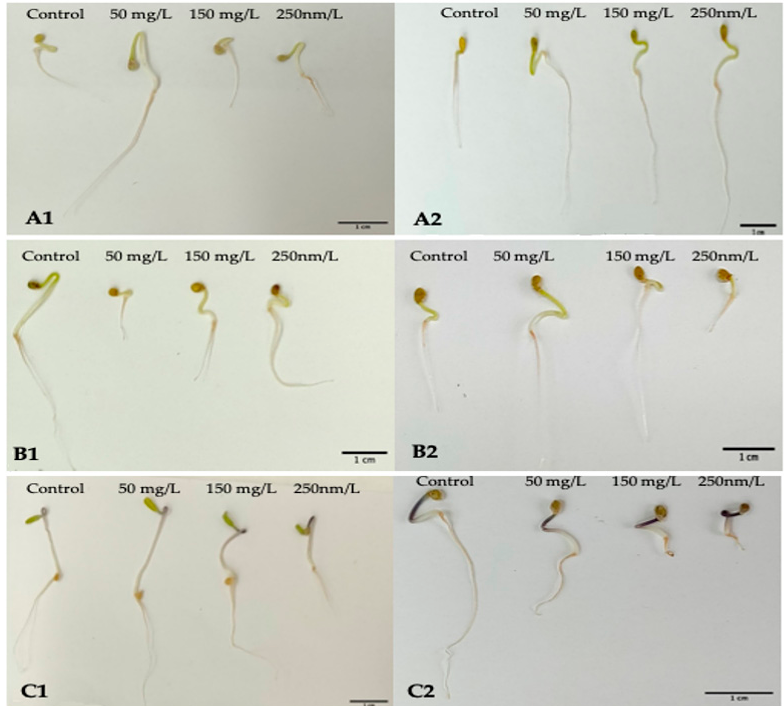
Figure 9. The picture of seedlings after 5 days of incubation. The seedlings of Maskotka cultivar treated with the suspensions of NPs ( A1 ) <50 nm and ( A2 ) <100 nm. The seedlings of Granit cultivar treated with the suspensions of NPs ( B1 ) <50 nm and ( B2 ) <100 nm. The seedlings of Malinowy